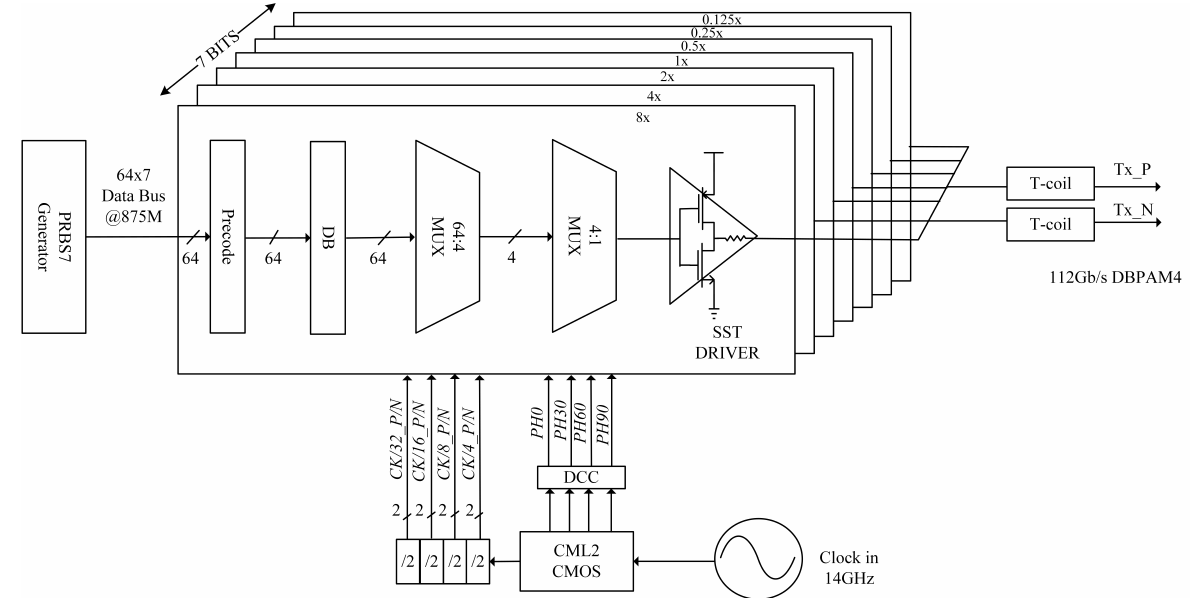
Figure 2. Transmitter system